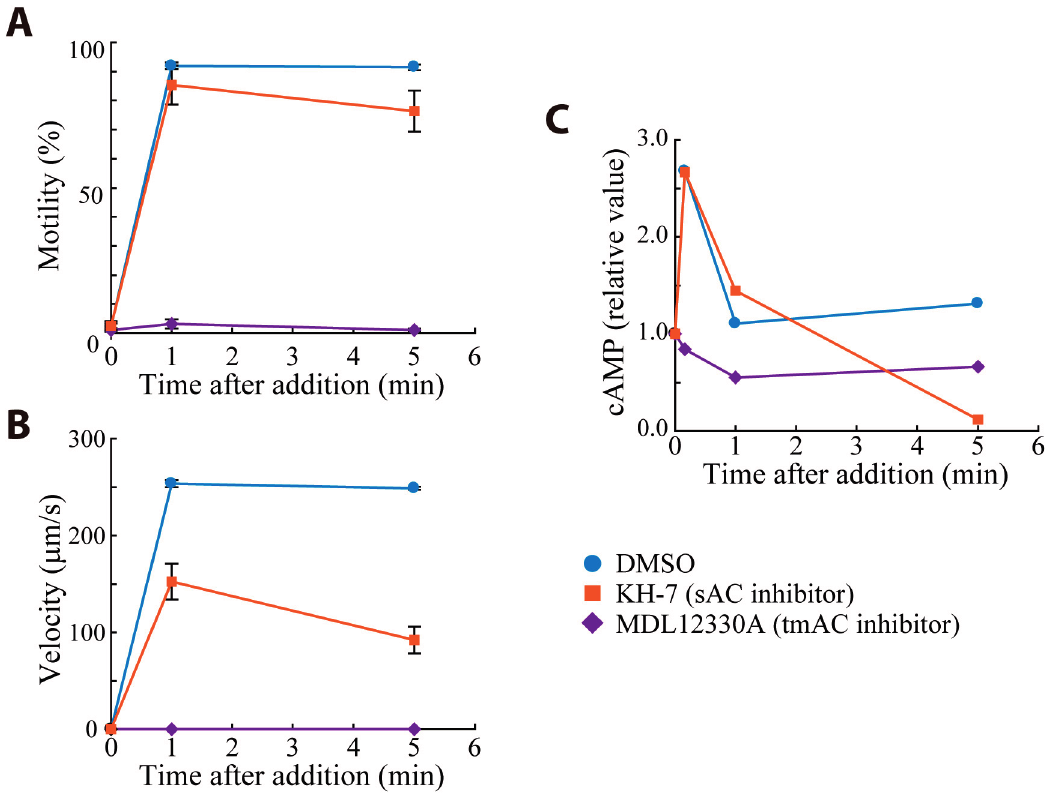
Figure 3. Effects of AC inhibitors on sperm activating and attracting factor (SAAF)-induced activation of Ciona sperm motility and cAMP synthesis. The percentage of motile sperm ( A ); curvilinear velocity ( B ) and intracellular cAMP level ( C ) were measured before, 1 min and 5 min after the addition of 100 nM SAAF. Sperm were treated with 0.5% dimethyl sulfoxide (DMSO, control), 100 μ M MDL12330A or 10 μ M KH-7 respectively for 3 min before SAAF addition. Values are means ± standard error (SE) of the results from three